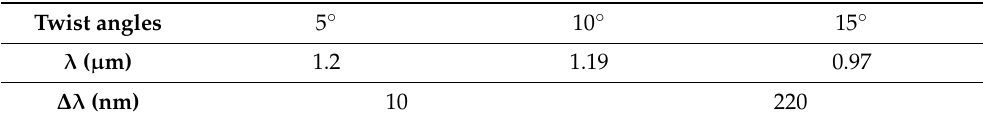
Table 1. Tuning using twist angles.